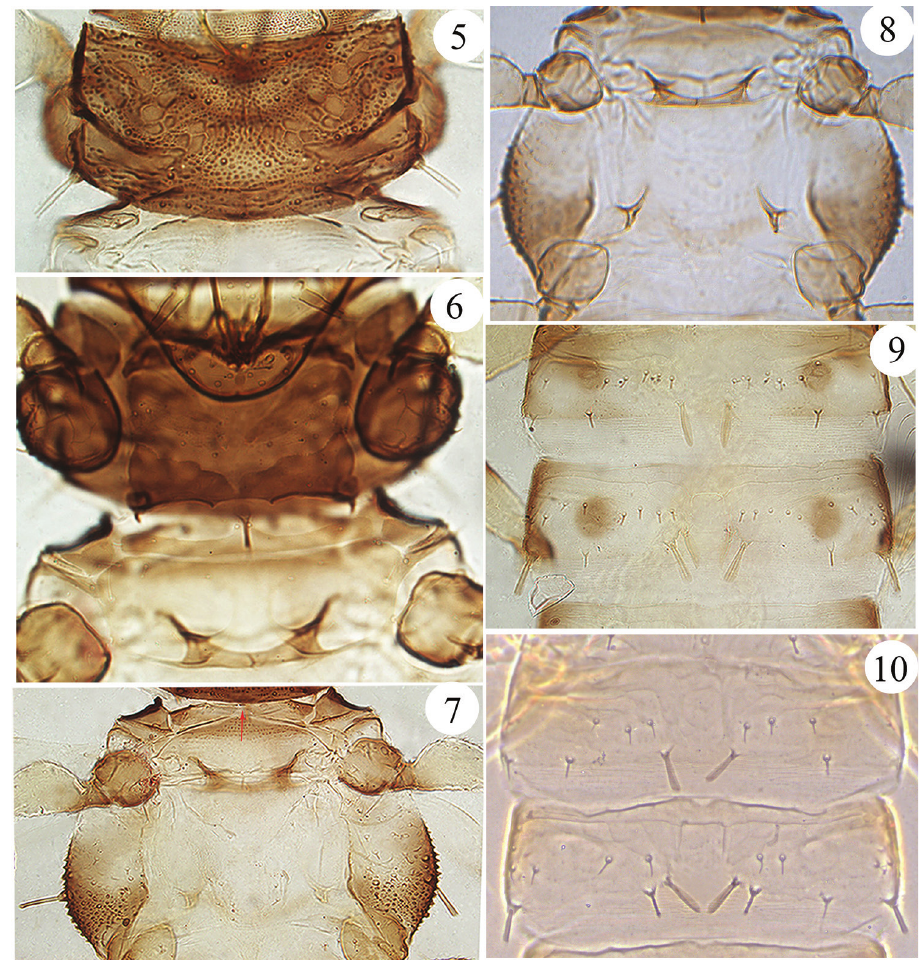
Figures 5–10. Baenothrips cuneatus sp. n. 5 pronotum 6 ventral view of prothorax 7 dorsal view of pterothorax (arrow indicates mesoacrotergite constricted medially) 8 ventral view of pterothorax (show meso- and metasternal furcae) 9 abdominal tergites II–III of female 10 abdominal tergites II–III of male.